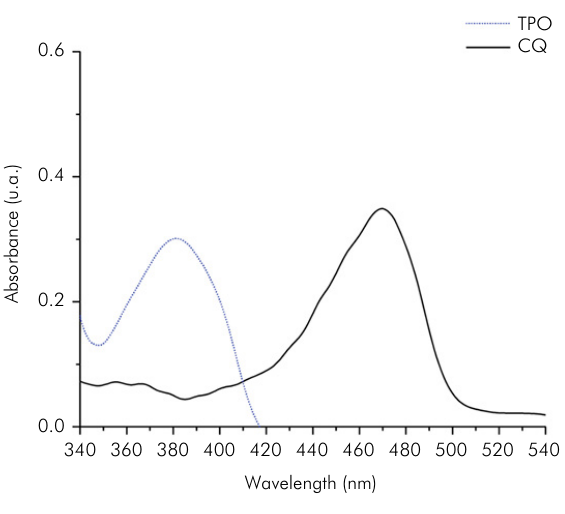
Figure 2. Camphorquinone (CQ) and diphenyl(2,4,6- trimethylbenzoyl)-phosphine oxide (TPO) in the 340-540 nm